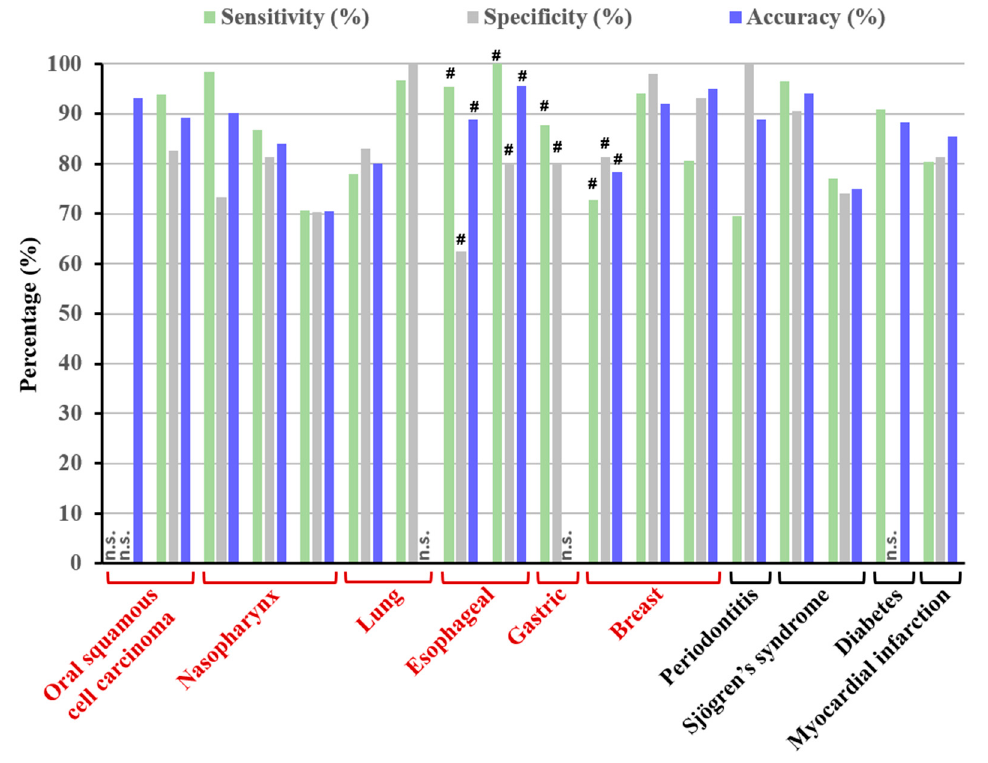
Figure 3. Percentage of sensitivity, specificity, and accuracy of selected studies. # indicates the minimal result according to the different categories of patients; red indicates diseases corresponding to cancers; n.s., not stated.